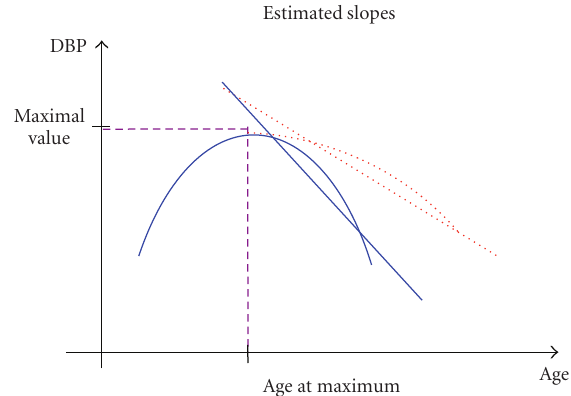
Figure 2: Dynamic characteristics of a hypothetical non- monotonically changing physiological index (denoted here “DBP”) considered as potential risk factors: 1) Maximum value; 2) Age at which the maximum has been reached; 3) Average rate of decline after reaching the maximum. The figure illustrates evaluation of average rates of decline in two individuals having the same pattern of increase until reaching the maximum and di ff erent patterns of decline after reaching the maximum: a) the solid line for a rapidly declining index and its approximation by a straight line; b) the dotted line for a slowly declining index and its linear approximation. The slopes of respective straight lines are considered as risk factors for mortality and onset of “unhealthy